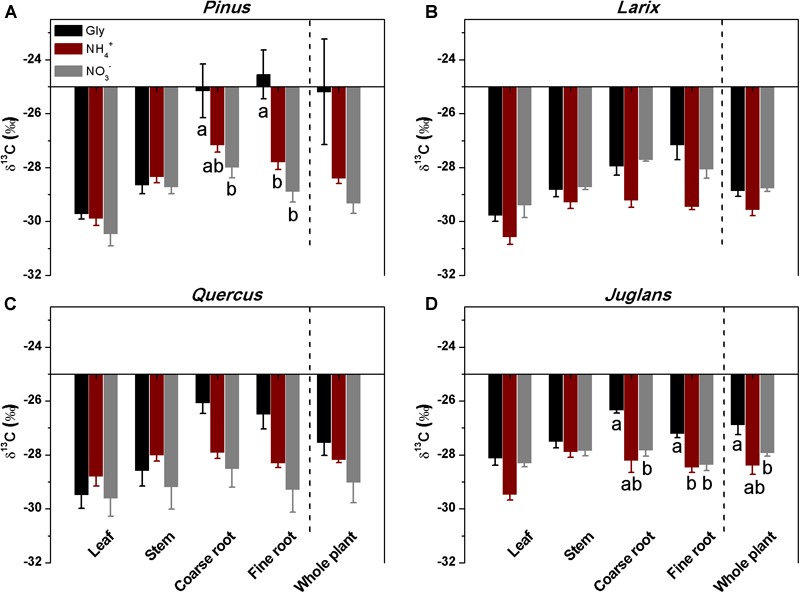
Stable carbon isotope composition (δ13C) of different plant organs of the four studied species (A–D) that had received mixtures of glycine, ammonium and nitrate, with a single form isotopically labeled. The δ13C of the whole plant was calculated from mass-weighted δ13C of plant organs (Means ± SE, n = 4). Different letters below the bars indicate significant differences in δ13C between N forms for each species (one-way ANOVA, P < 0.05).